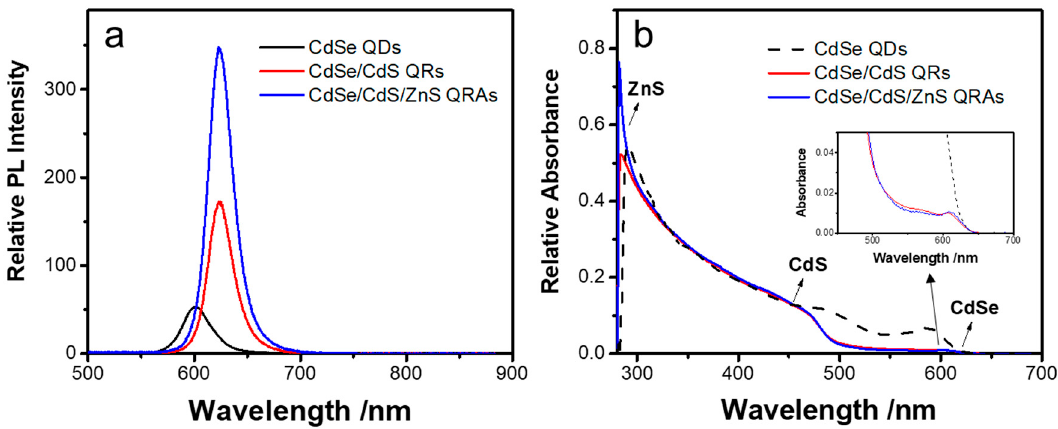
Figure 4. ( a ) Photoluminescence (PL) spectra and ( b ) UV-Vis absorption spectra of the CdSe QDs, CdSe/CdS QRs, and CdSe/CdS/ZnS QRAs.